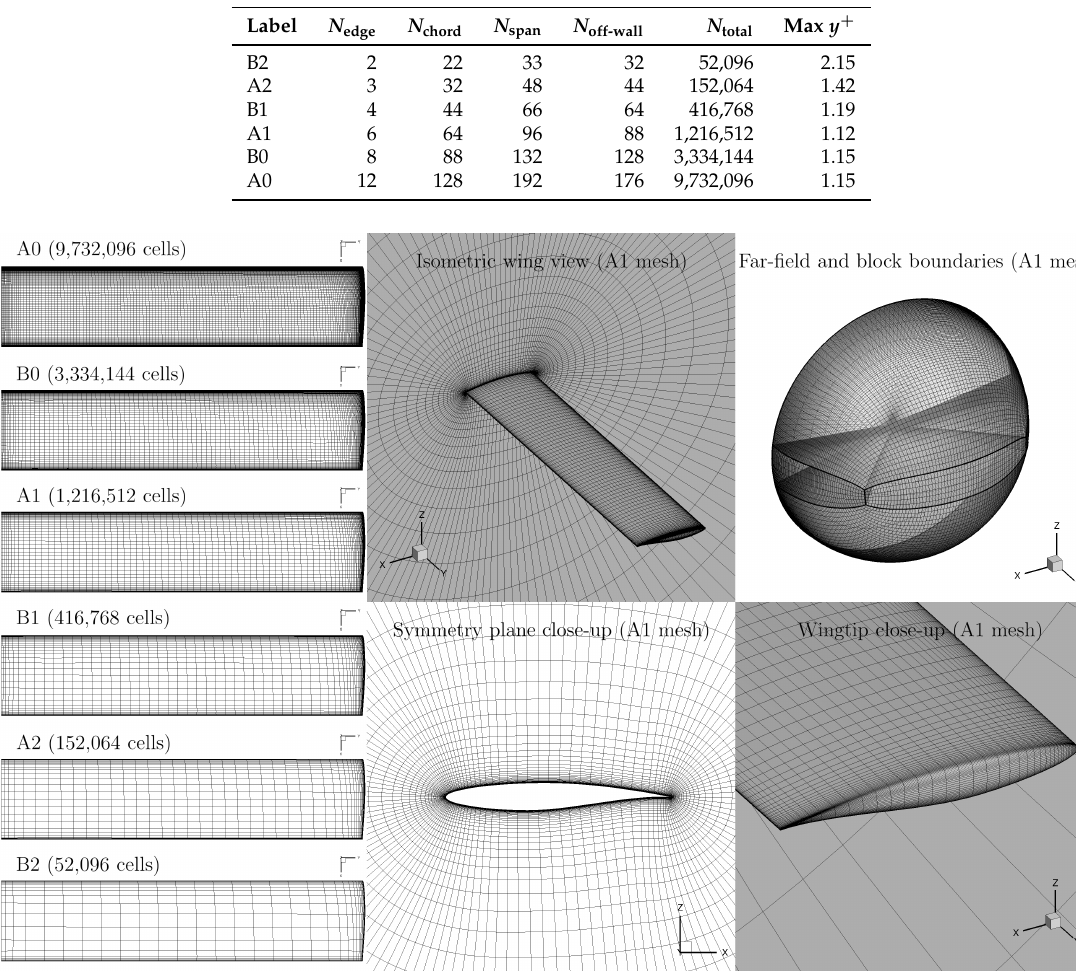
Figure 3. CFD meshes of baseline